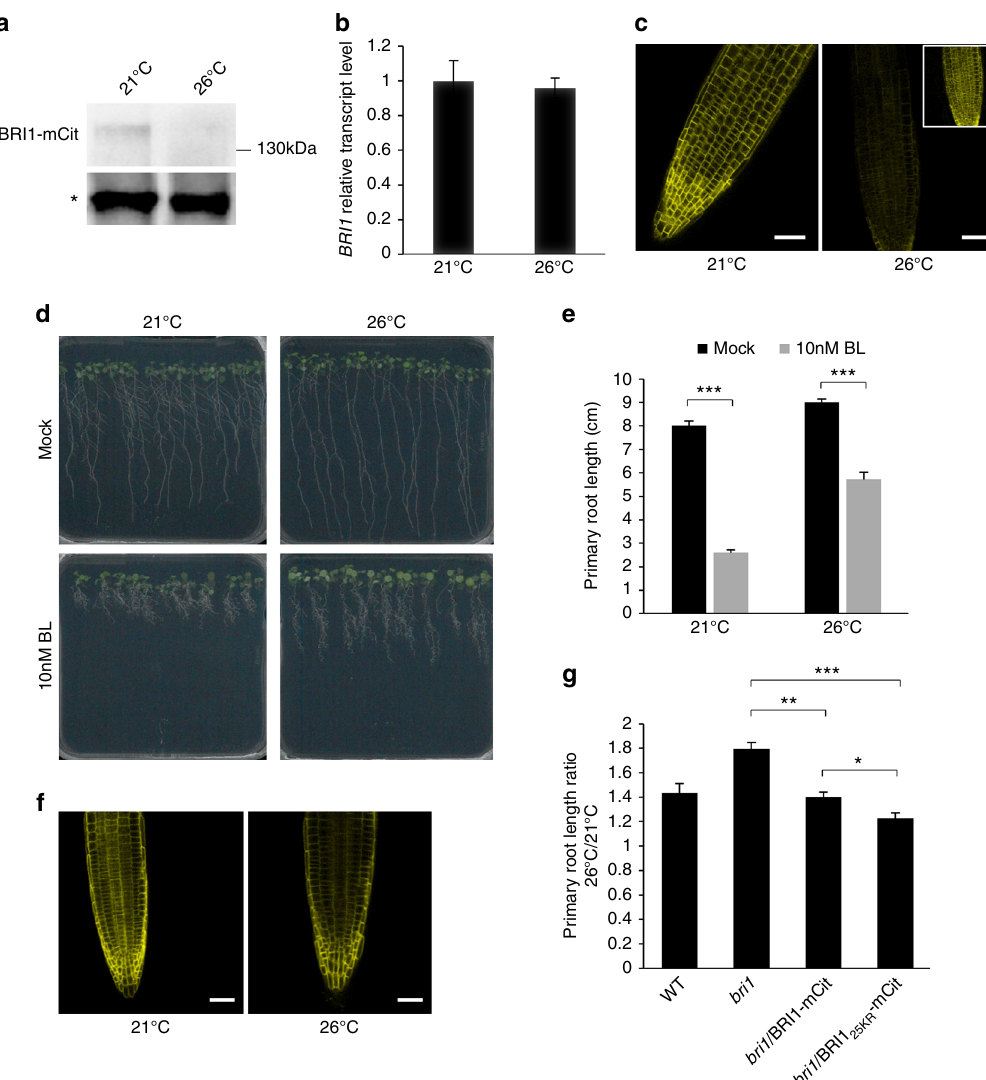
Fig. 5 Elevated ambient temperature impinges on BRI1 levels and brassinosteroid perception. a Western blot analyses monitoring the accumulation of BRI1 protein in 15-day-old plants expressing a functional BRI1-mCitrine (mCit) fusion protein, under the control of the BRI1 promoter, using anti-GFP antibodies. The asterisk represents a non-speci fi c band used as loading control. A representative blot is shown. b Quantitative RT-PCR monitoring BRI1 gene expression in roots from wild-type plants grown at 21 or 26 °C (mean ± s.d., n = 3). The difference in BRI1 gene expression at 21 and 26 °C is not statistically signi fi cant. c In fl uence of elevated ambient temperature on BRI1-mCit protein accumulation in roots. Similar confocal detection settings were used to compare plants grown at 21 and 26 °C. Representative images are shown. Inset shows higher gain. Scale bar, 50 µ m. d Phenotype of 15-day-old wild-type plants grown at 21 or 26 °C and treated with mock or 10 nM brassinolide ( BL ). Representative images are shown. e Primary root length of plants grown as in d (mean ± s.d., n = 25). The asterisks indicate a statistically signi fi cant difference ( t -test, P < 0.0001). f In fl uence of increased growth temperature on BRI1-mCit and its non-ubiquitinatable BRI1 25KR -mCit variant. Similar confocal detection settings were used to compare the effect of temperature. Representative images are shown. Scale bar , 50 µ m. g Ratio of primary root length from wild-type, bri1 , bri1 /BRI1-mCit, and bri1 /BRI1 25KR -mCit plants grown at 21 and 26 °C for 15 days (mean ± s.d., n = 4). The asterisks indicate a statistically signi fi cant difference (Kruskal – Wallis; * P < 0.01; ** P < 0.001; *** P <